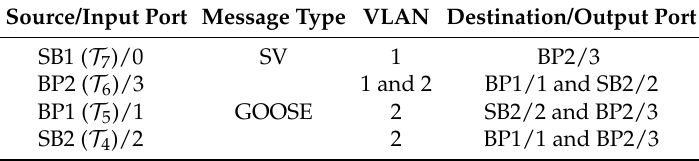
Table 6. T1-1 communication with VLAN tagging.